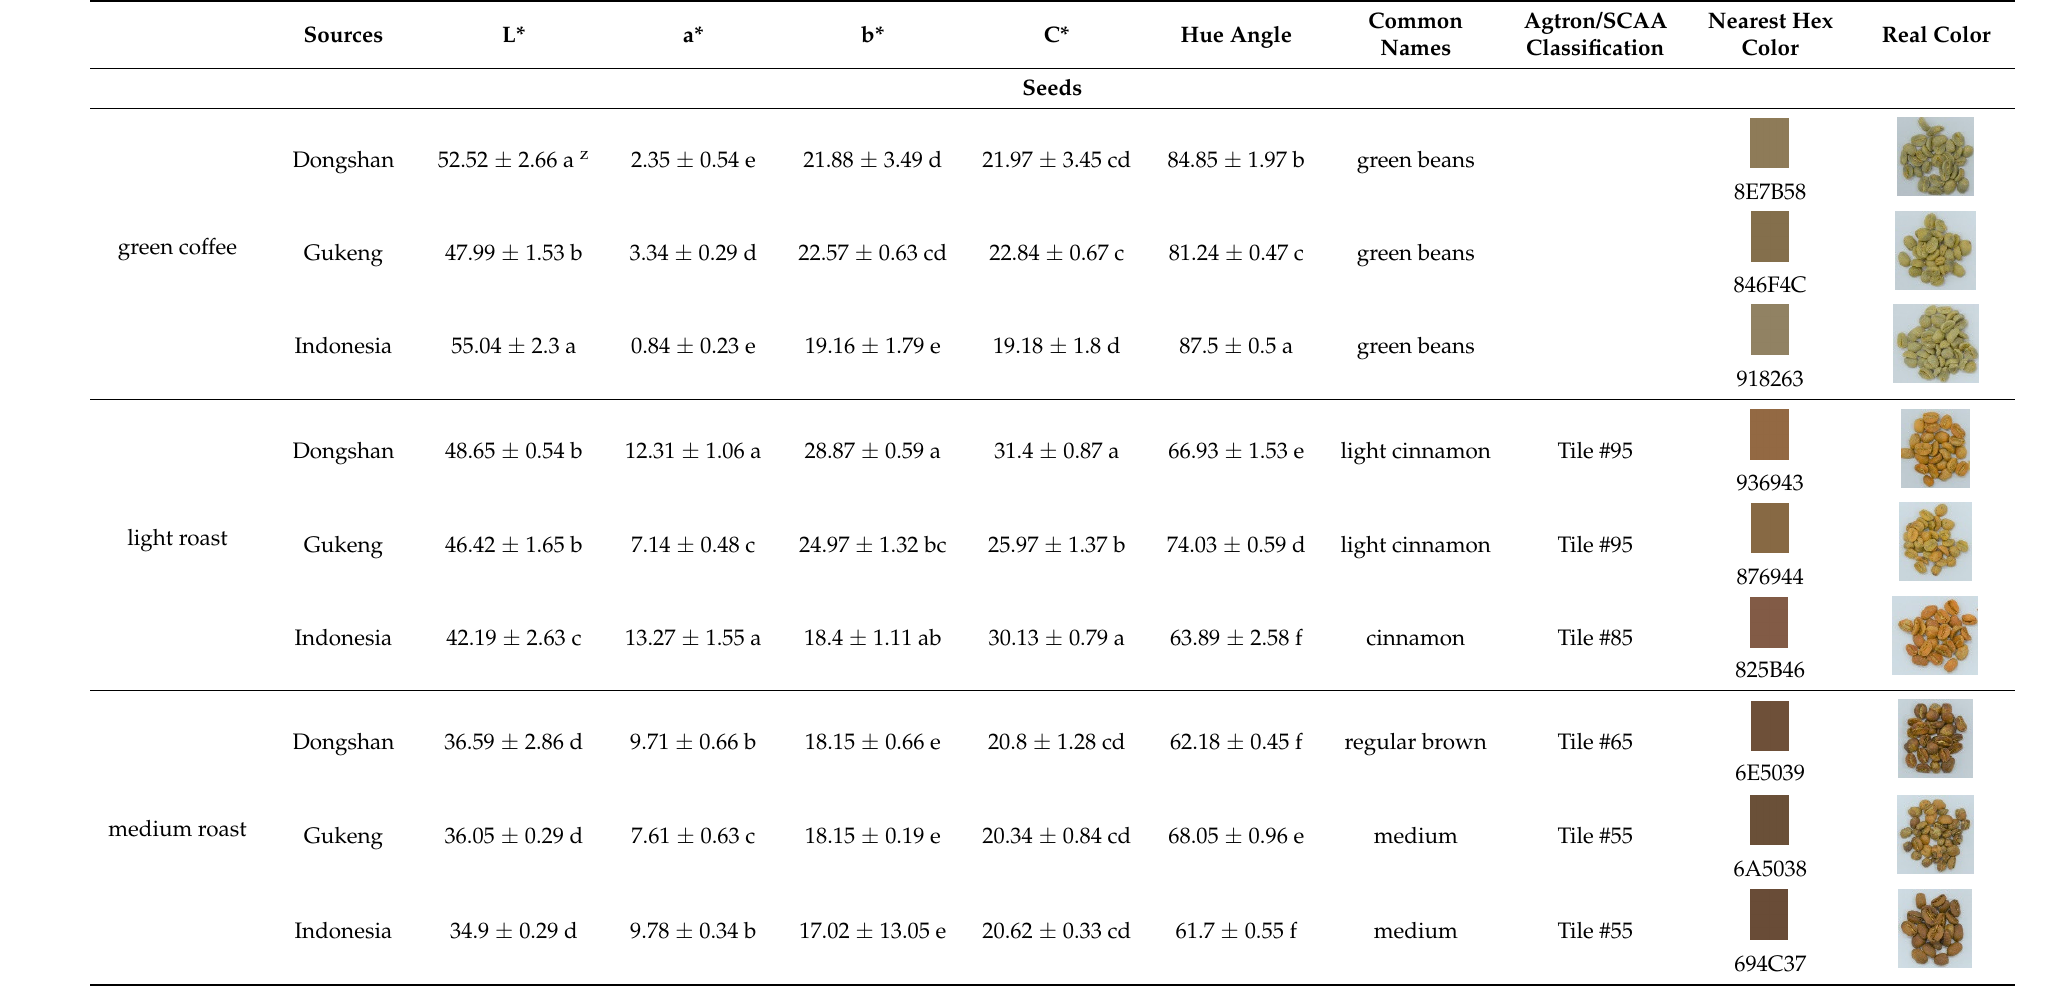
Table 1. CIE L*, a*, and b* values of different sources and roasting degrees of coffee beans.